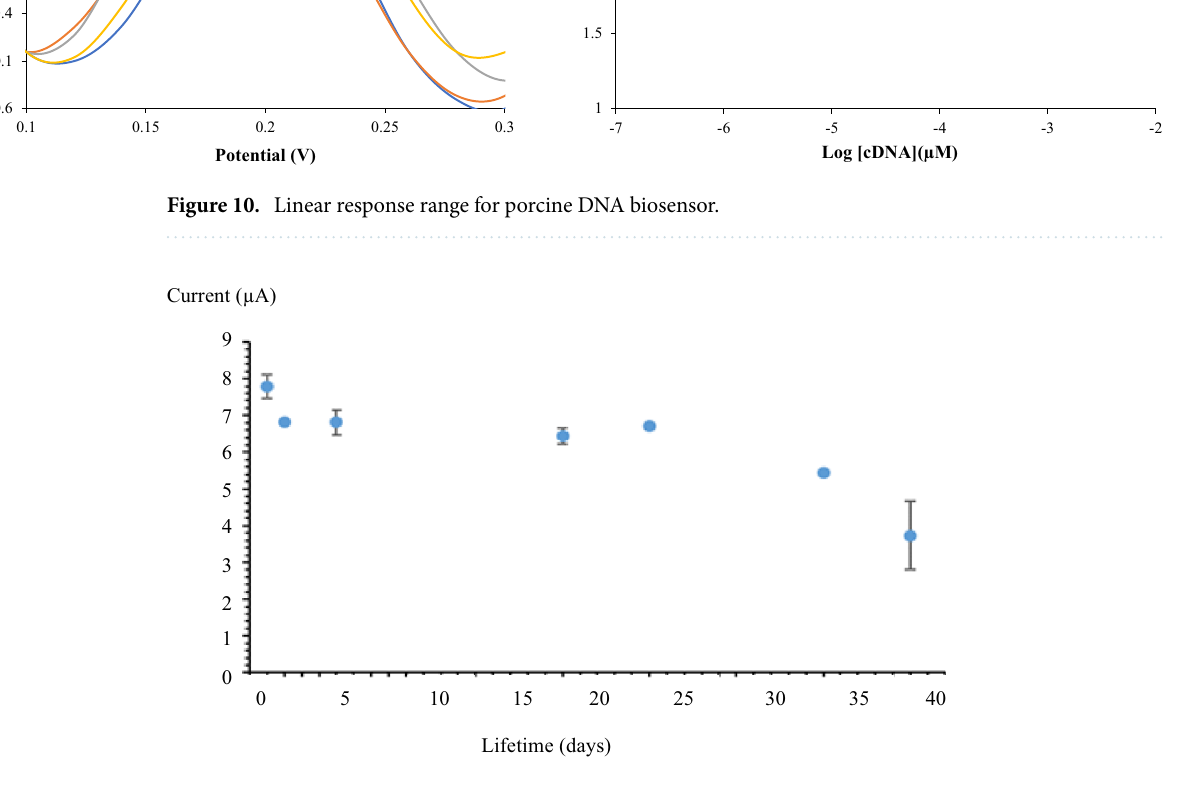
Figure 11. Shelf life of porcine DNA